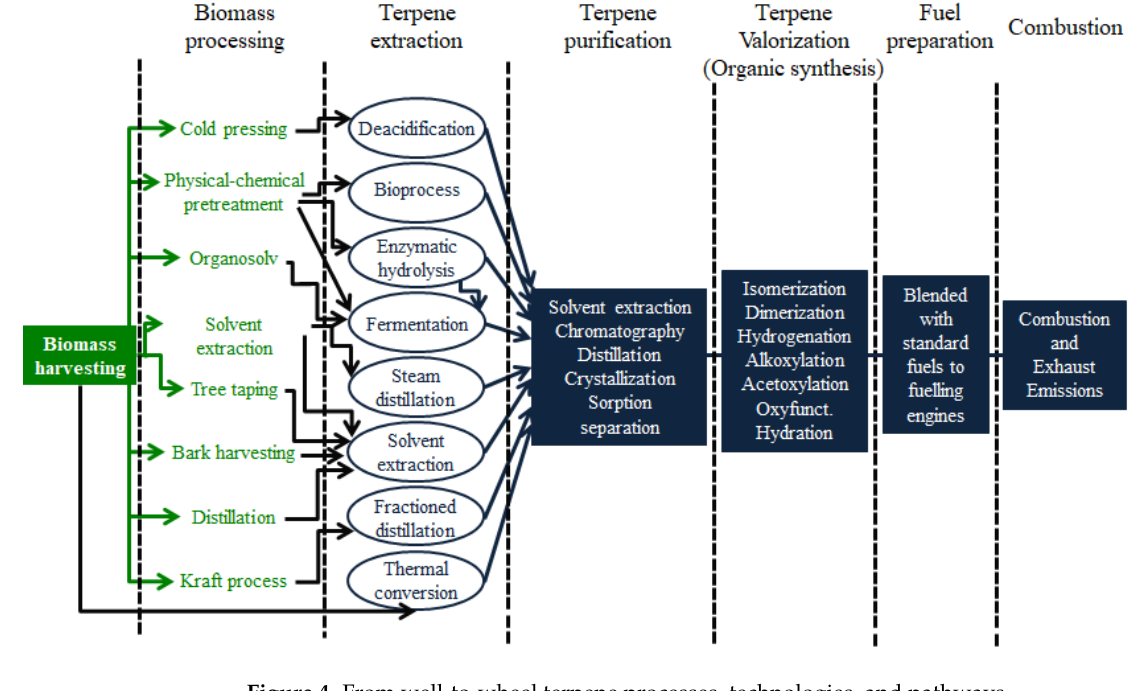
Figure 4. From well-to-wheel terpene processes, technologies, and pathways.